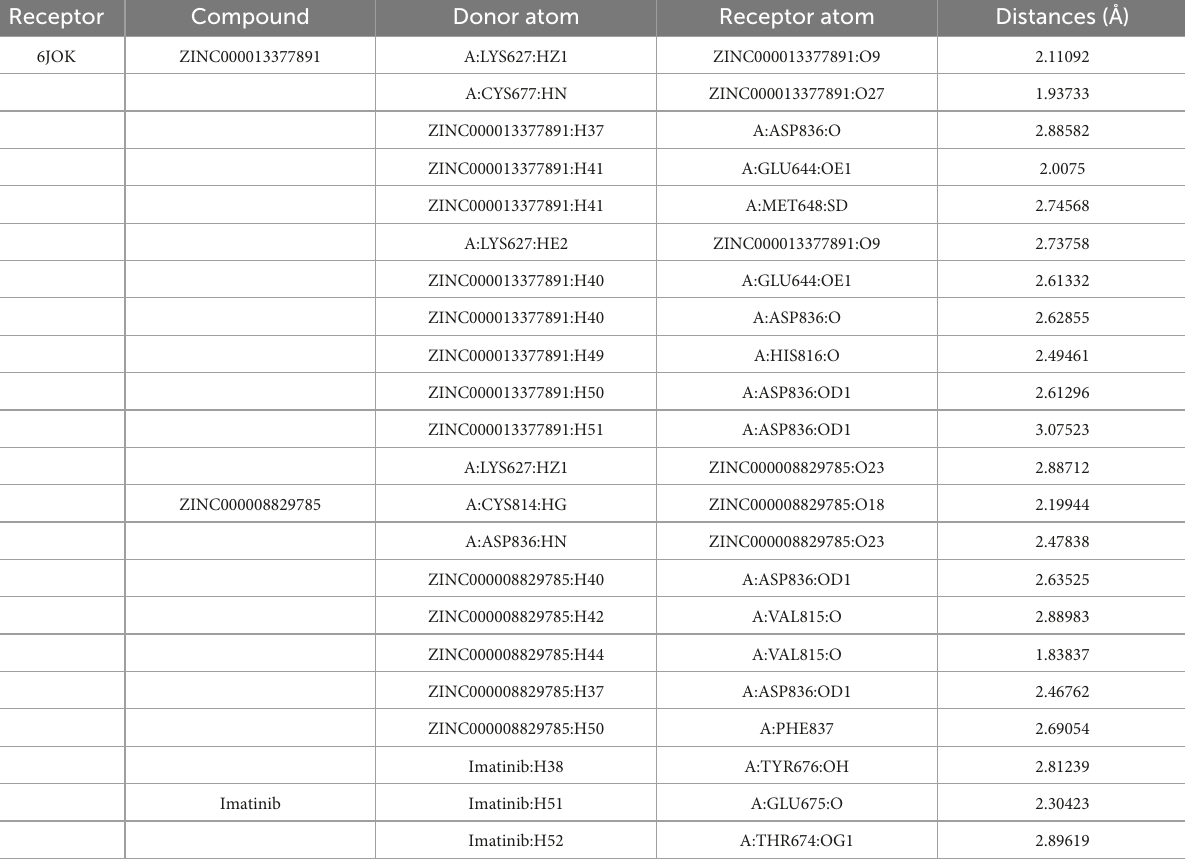
TABLE 5 Hydrogen bond interaction parameters for each compound with platelet-derived growth factor receptor α (PDGFRA). Receptor Compound Donor atom Receptor atom Distances (Å) 6JOK